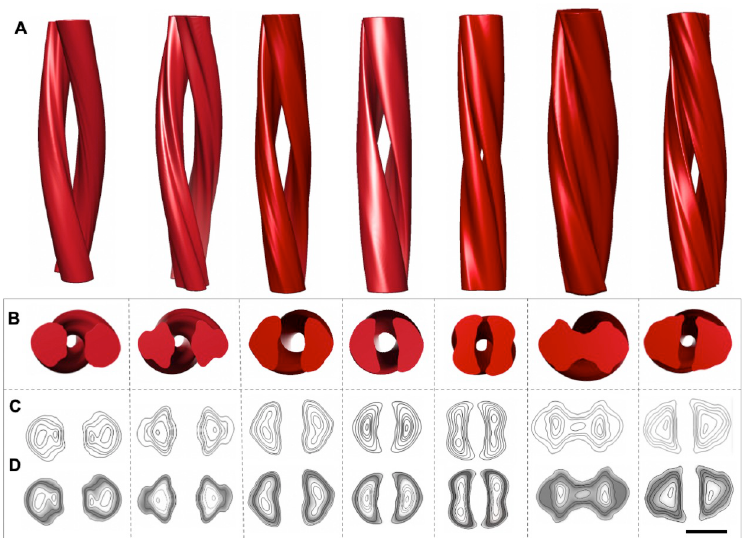
Fig 8. Gallery of independent, 3D reconstructions of two-protofilament L-type BSE fibrils. ( A ) 3D volumes of different two-protofilament L-type BSE fibrils. ( B ) Cross-section views of the helical reconstructions. ( C ) Contour maps and ( D ) density maps of the reconstructed volumes. Scale bar = 10 nm.